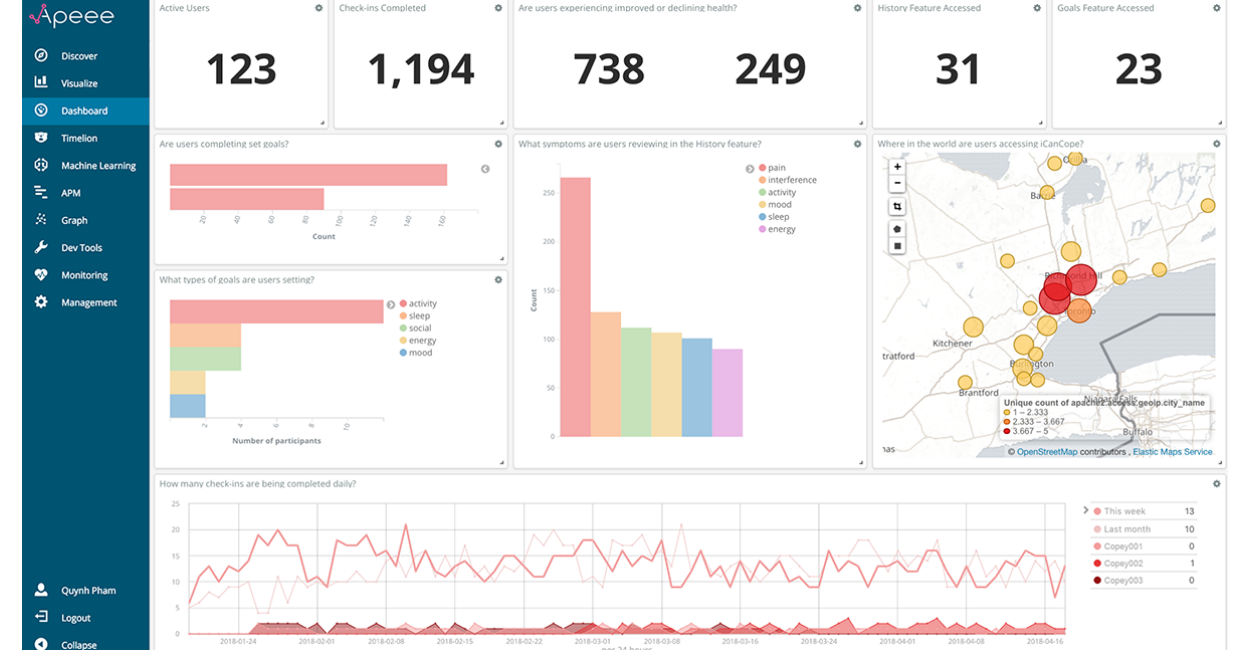
Figure 2. APEEE dashboard with a subset of analytic indicators of effective engagement with iCanCope. APEEE: Analytics Platform to Evaluate Effective